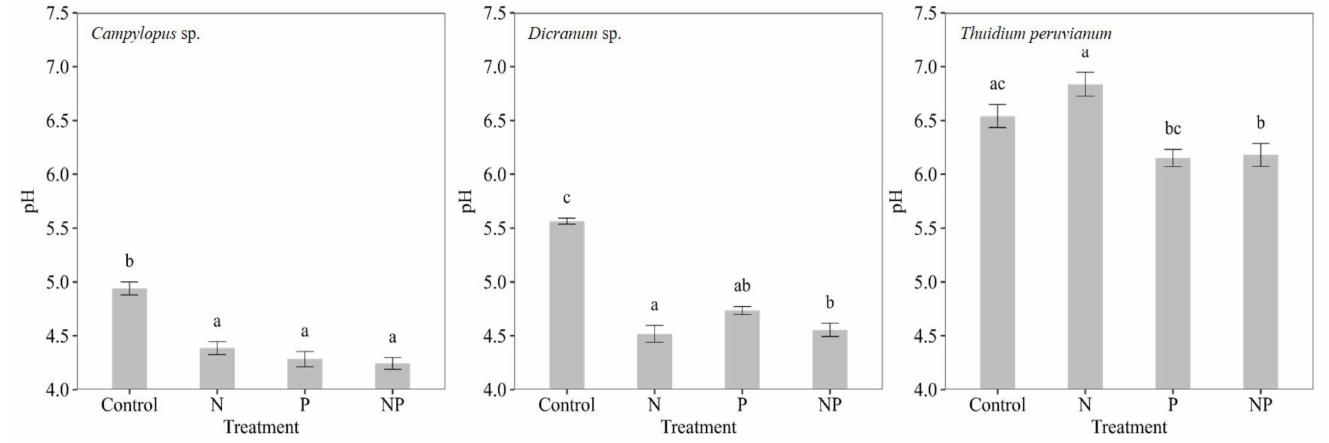
Figure 6. Mean pH values for each moss species ( Campylopus sp., Dicranum sp. and Thuidium peruvianum ) after nutrient additions (control, nitrogen (N), nitrogen and phosphorus (NP) and phos- phorus (P)). Different letters (a/b/ab/ac/bc/c) show statistically significant (Tukey test) differences between